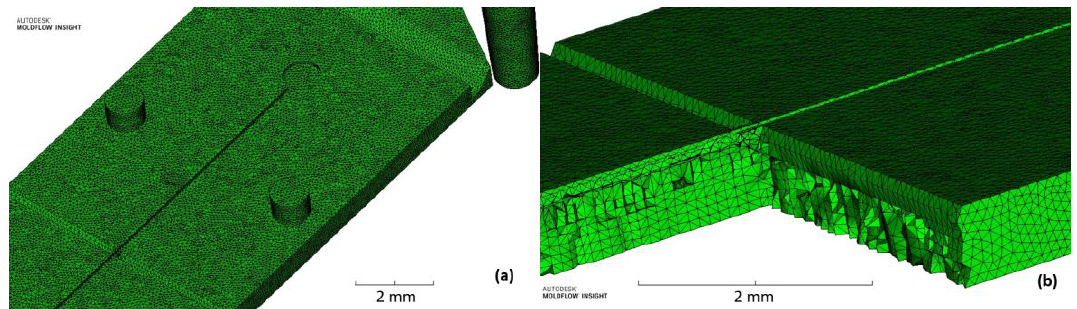
Figure 2. ( a ) Overview of mesh size (fine mesh at 100 µm with merge tolerance 10 µm) and ( b ) 3D mesh with number of element through thickness (10 elements).